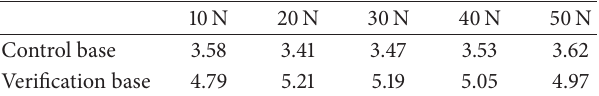
Table 5: Vibration level difference of the two bases for different exciting forces (dB).